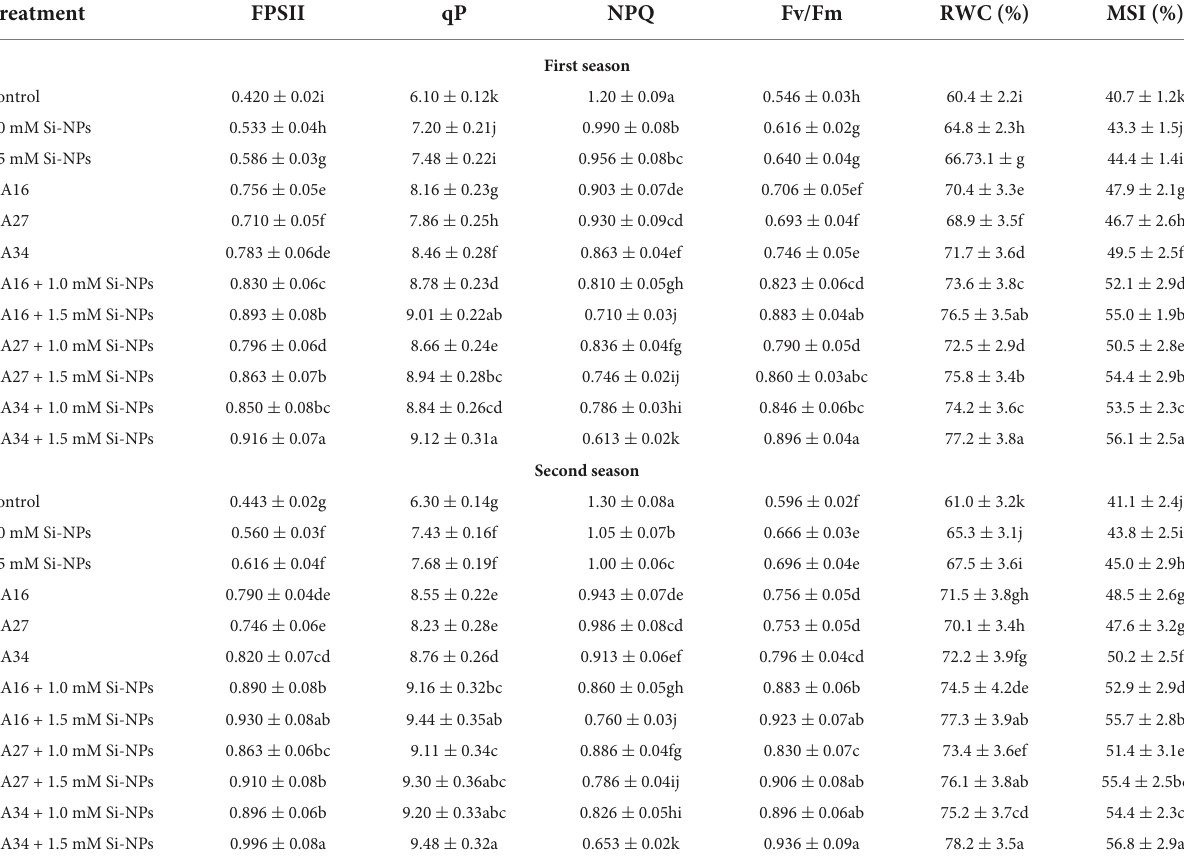
TABLE 4 Effect of soil application with calcium carbonate precipitating bacteria (CCPB), Bacillus lichenforms (MA16), Bacillus megaterium (MA27), and Bacillus subtilis (MA34), and foliar application with silicon nanoparticles (Si-NPs) on chlorophyll fluorescence parameters, RWC and MSI of wheat plants (cv. Misr